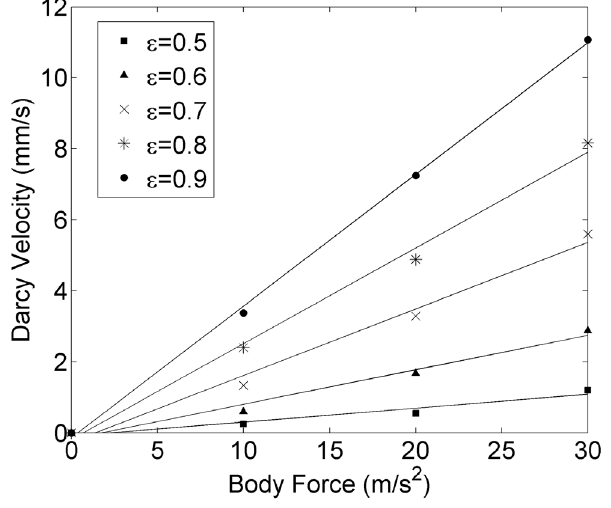
Figure 4. Representative steady-state Darcy velocity as a function of body force for various